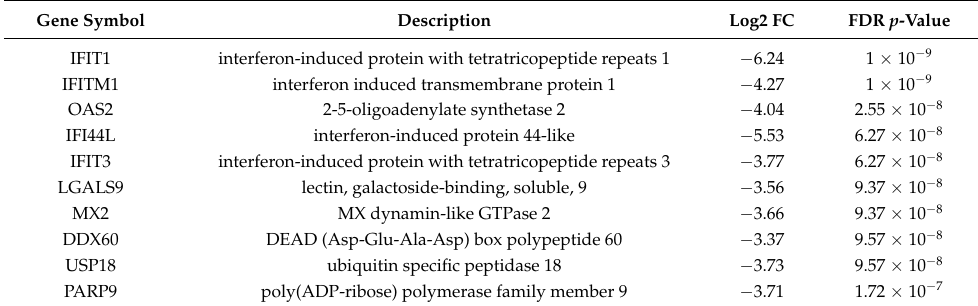
Table 2. Top ten down-regulated genes in VECs cultured in CM miRNA.